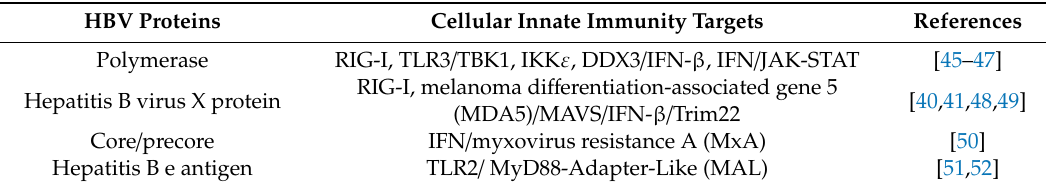
Table 1. Di ff erent cellular innate immunity targets of HBV